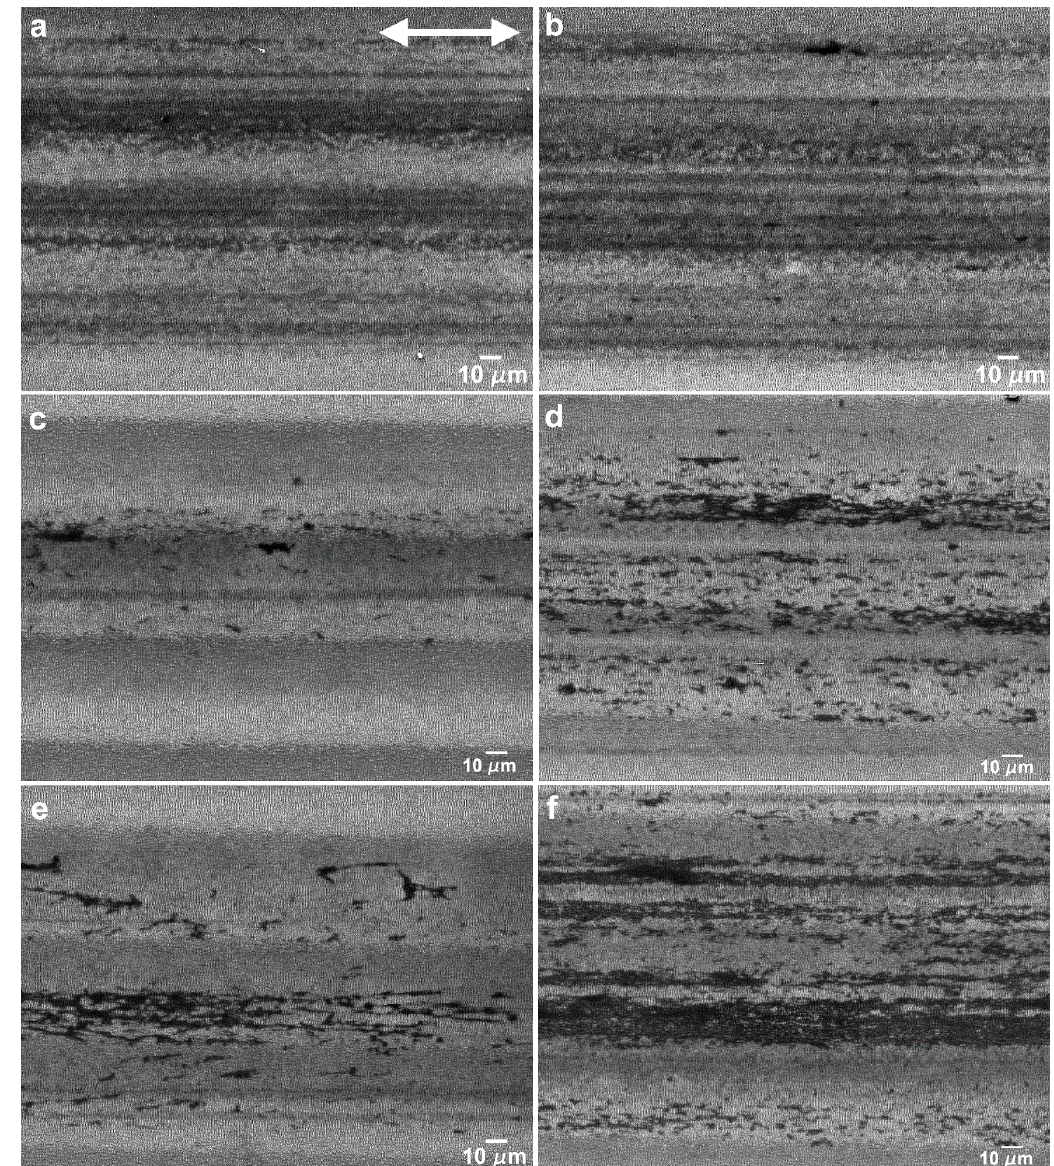
Figure 14. SEM micrographs of the central region of wear tracks produced in the perpendicular sliding direction at 5 mN after ( a ) 50 cycles and ( b ) 1000 cycles; at 10 mN after ( c ) 50 cycles and ( d ) 1000 cycles and at 25 mN after ( e ) 50 cycles and ( f ) 1000 cycles. The double arrow indicates the sliding direction.